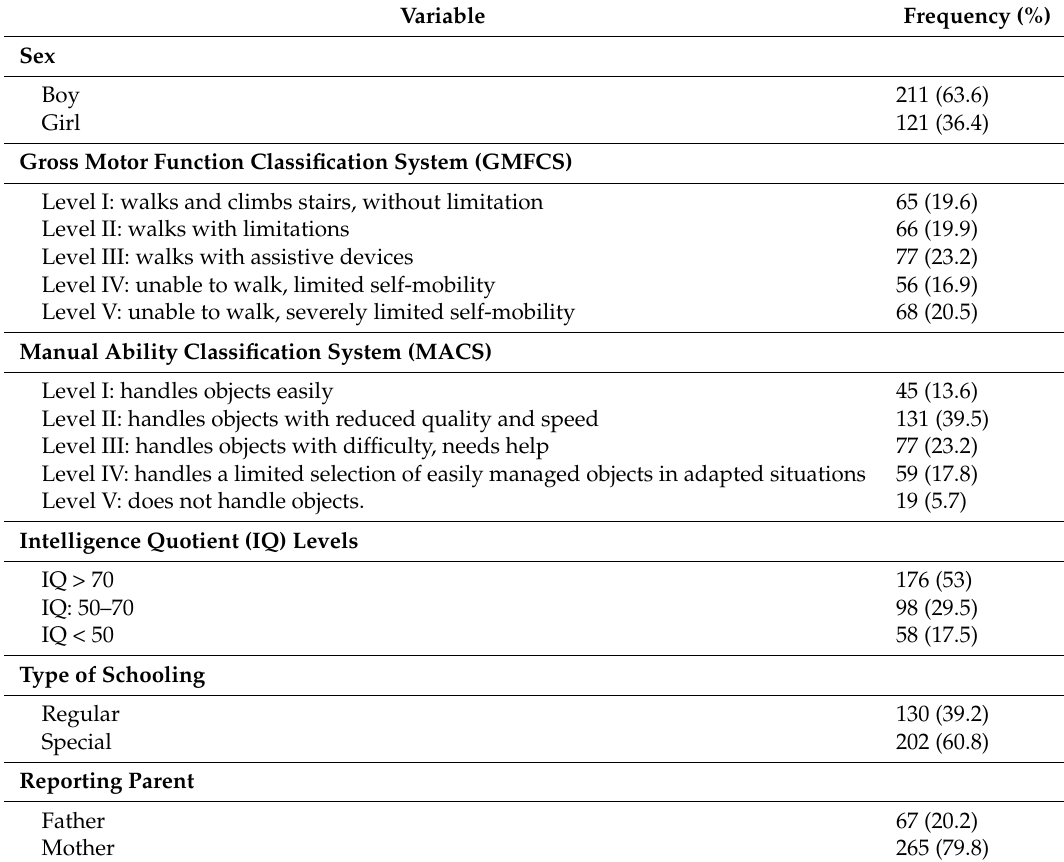
Table 1. Personal and sociodemographic characteristics of children ( N = 332).